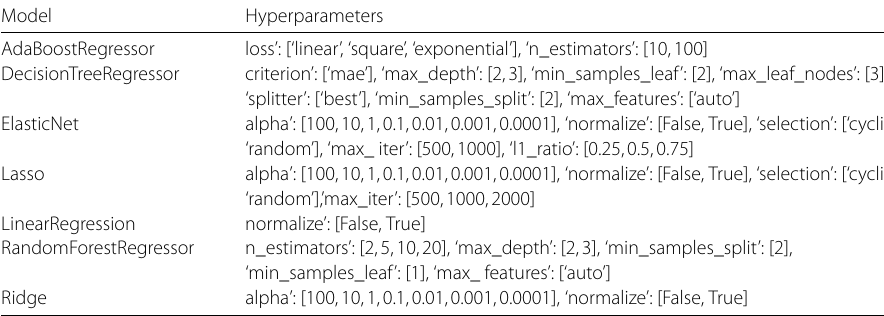
Table 17 Models and hyperparameters used for SWLS and WHO-5 regression Model